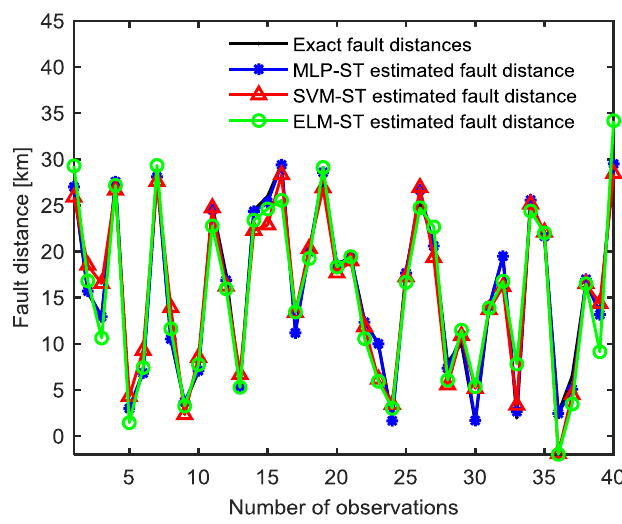
Figure 4 . Comparison of the Stockwell transform (ST) based non-optimized MLT predicted Figure 4. Comparison of the Stockwell transform (ST) based non-optimized MLT predicted and actual and actual fault distances, for the test dataset of applied phase-A-to-ground (AG) fault. fault distances, for the test dataset of applied phase-A-to-ground (AG) fault. Energies 2018 , 11